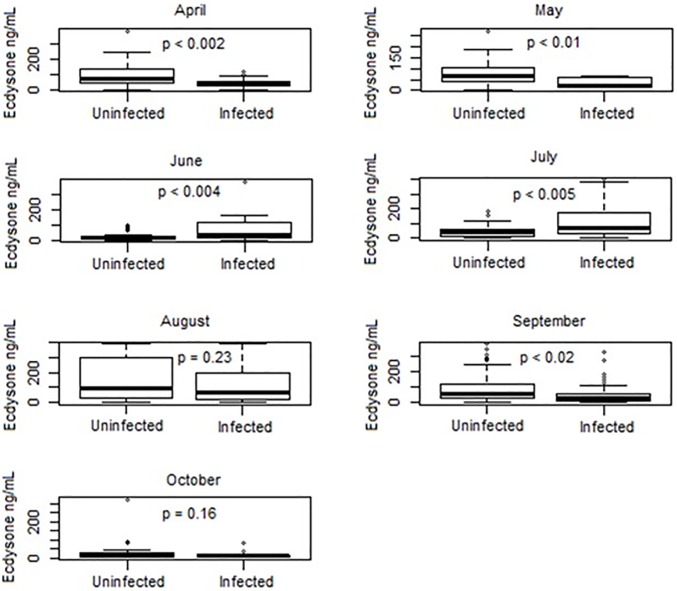
Ecdysone concentration by month for infected and uninfected crabs.Monthly boxplots of pooled ecdysone concentrations for uninfected and infected crabs are shown. The p-values listed corresponds to the t-test of ecdysone concentration between infected and uninfected crabs for each month.